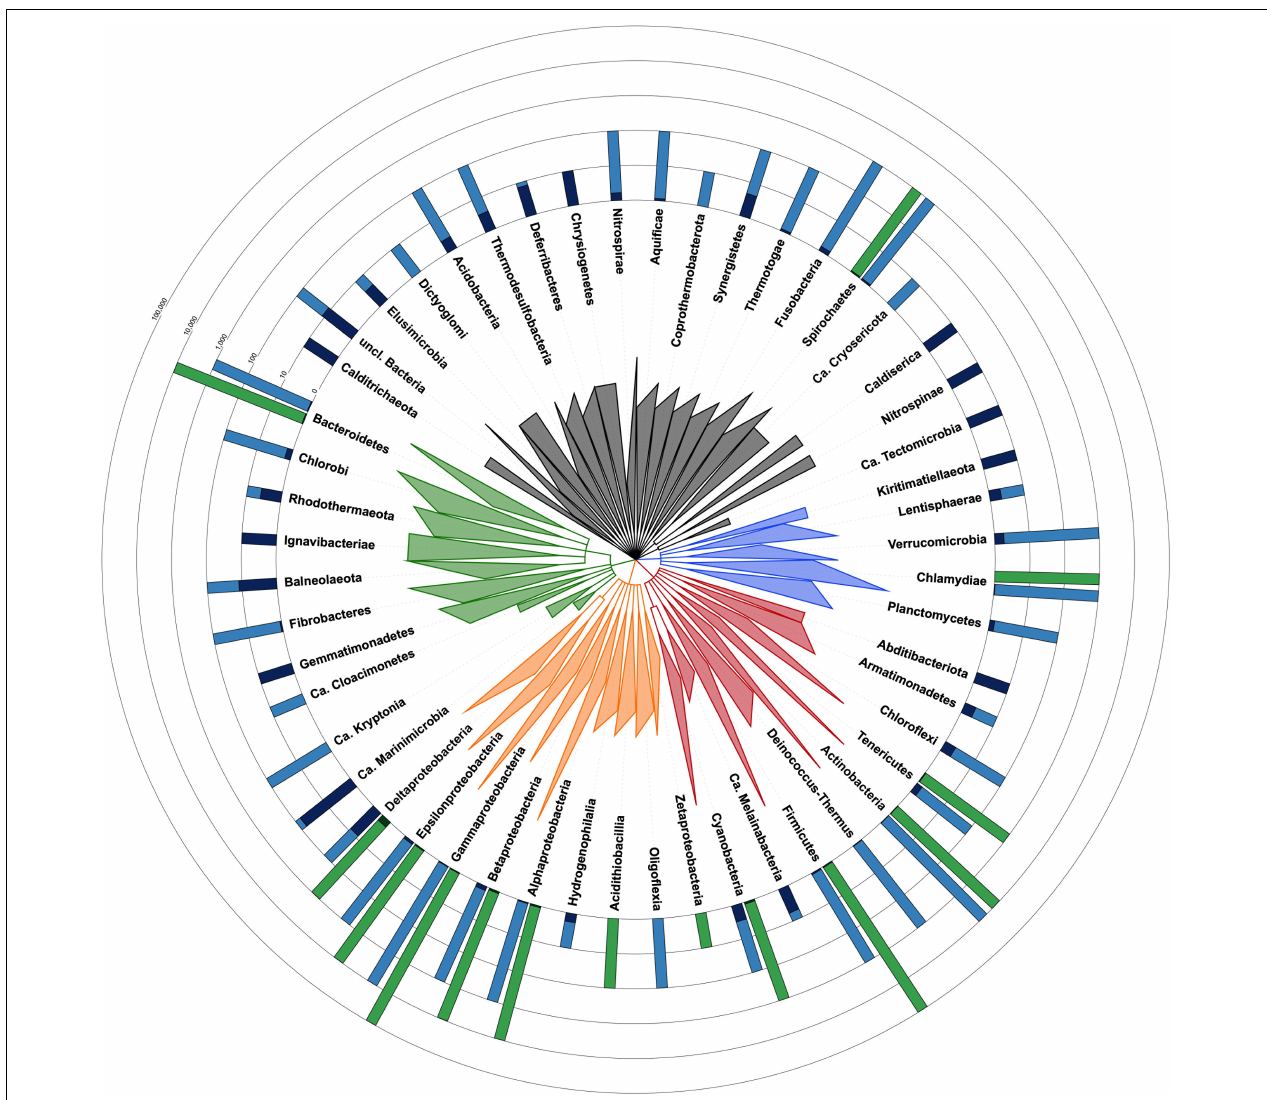
FIGURE 1 | Taxonomic tree of the bacterial domain showing the fraction of contaminated genomes in each phylum with each method. Taxon identifiers of the 111,088 RefSeq bacterial genomes were passed to NCBI Common Tree tools to construct the tree [parameters: (1) include unranked taxa, (2) expand all]. Tree visualization was performed with iTOL and branches were collapsed at the taxonomic levels reported in the tree. Triangles are proportional to taxonomic depth. Proteobacteria are colored in orange, FCB group in green, Terrabacteria in red, PVC group in blue and the other phyla in dark gray. Green barplots are for genomes evaluated with CheckM and blue barplots are for Physeter. The fraction of genomes with a contamination level < 5% is shown in a light color whereas those ≥ 5% are shown in a dark color. The number of genomes evaluated with each method is indicated by the height of the barplot on a ceiled logarithmic scale. For simplicity, the estimates for Ca. Saccharibacteria (2 contaminated and 12 uncontaminated genomes), candidate division NC10 (2 contaminated genomes), Ca. Atribacteria (2 contaminated genomes), and Ca. Bipolaricaulota (1 contaminated genome) are included in unclassified Bacteria. Completely contaminated phyla (e.g., Caldiserica, Nitrospinae, and Kiritimatiellaeota) are generally represented by very few genomes (i.e., one to three genomes). Among the more extensively studied phyla (11 to 37,487 genomes), some appear to be extremely contaminated, such as Balneolaeota, Synergistetes, and Chloroflexi, with, respectively, 54.5, 33.3, 16.9% of contaminated genomes, whereas other phyla are characterized by a very low contamination level, including Cyanobacteria (2.8%), Gammaproteobacteria (0.6%), or Chlamydiae